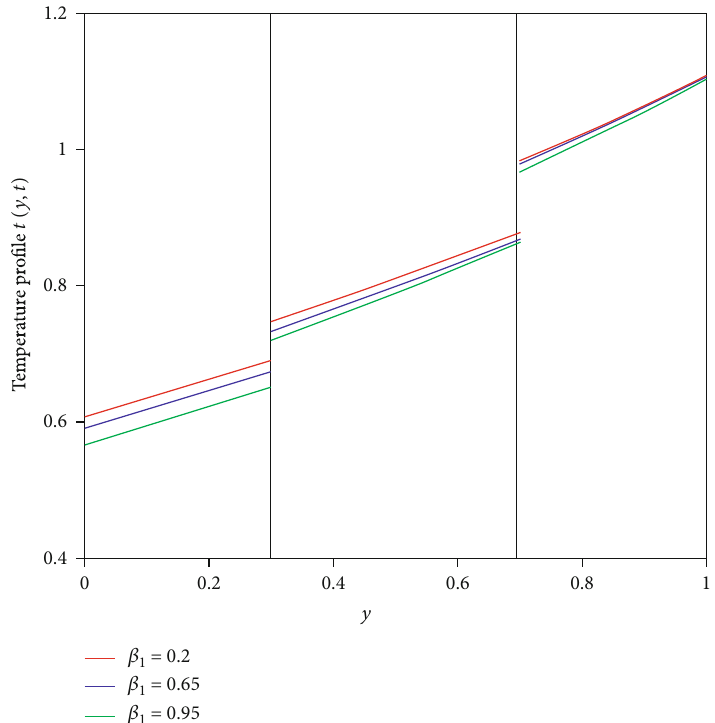
Figure 2: Temperature pro fi les T values of β . 1